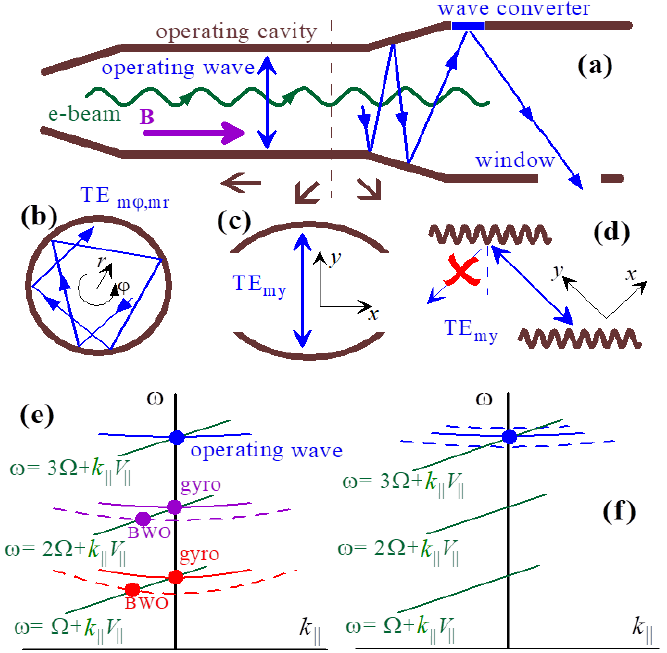
Figure 1. ( a ) Schematic of a gyrotron. ( b ) Circular cross-section of the conventional gyrotron cavity. ( c ) Cross-section of the open (in one of the transverse directions) quasi-planar cavity. ( d ) Cross-section of the photonic-structure cavity proposed in this paper. ( e ) Dispersion characteristic of different transverse modes in the conventional cavity, gyrotron-type excitation of the high-harmonic (N=3 in this example) operating wave, gytoron-type and BWO-type excitation of the lower-harmonic parasitic waves. ( f ) Dispersion characteristic of transverse modes in the photon- ic-structure cavity proposed in this paper.